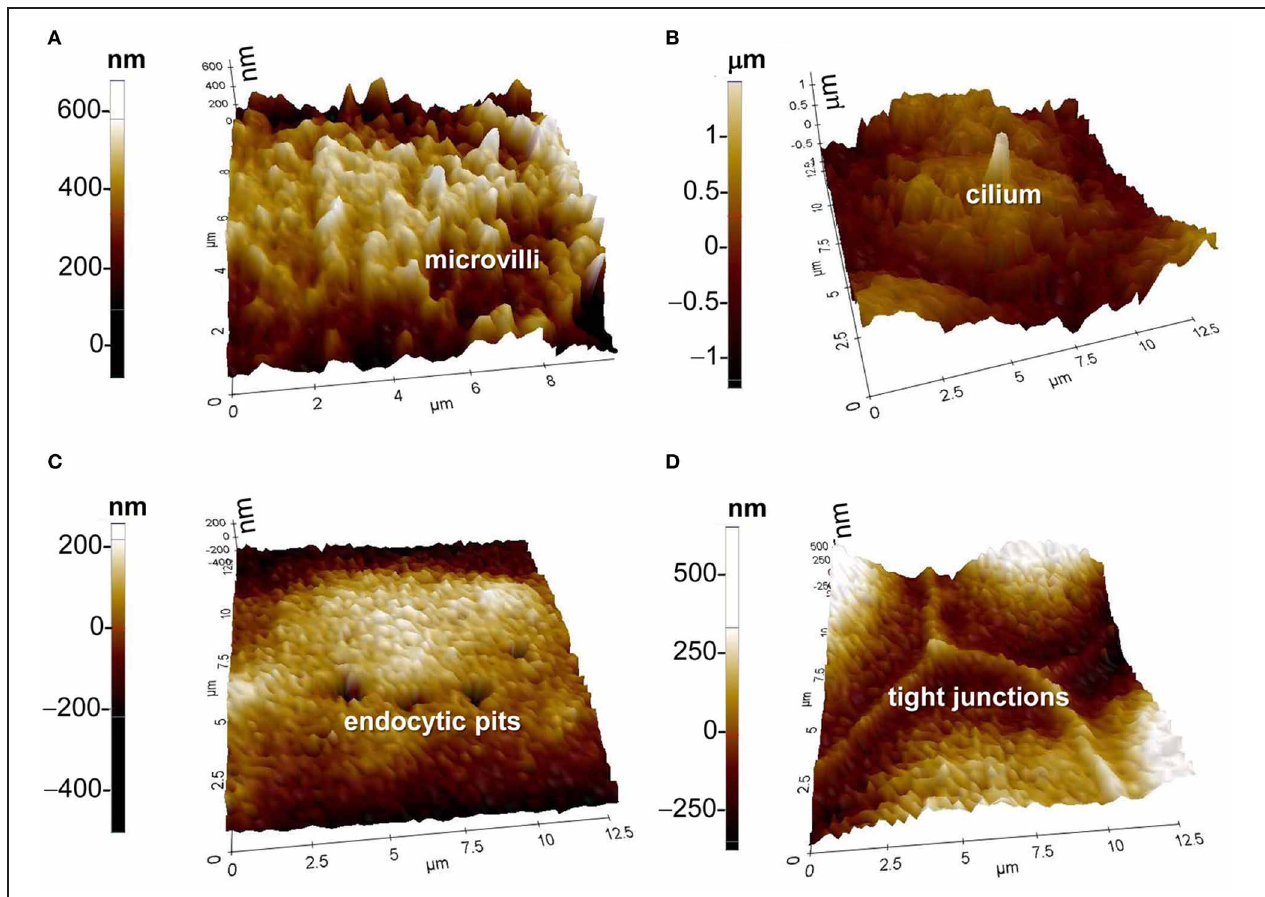
FIGURE 2 | SICM topographic images of (A) microvilli, (B) cilium, (C) endocytic pits, and (D) tight junctions. Images were achieved with the XE-Bio SICM which was purchased from Park Systems Corporation.